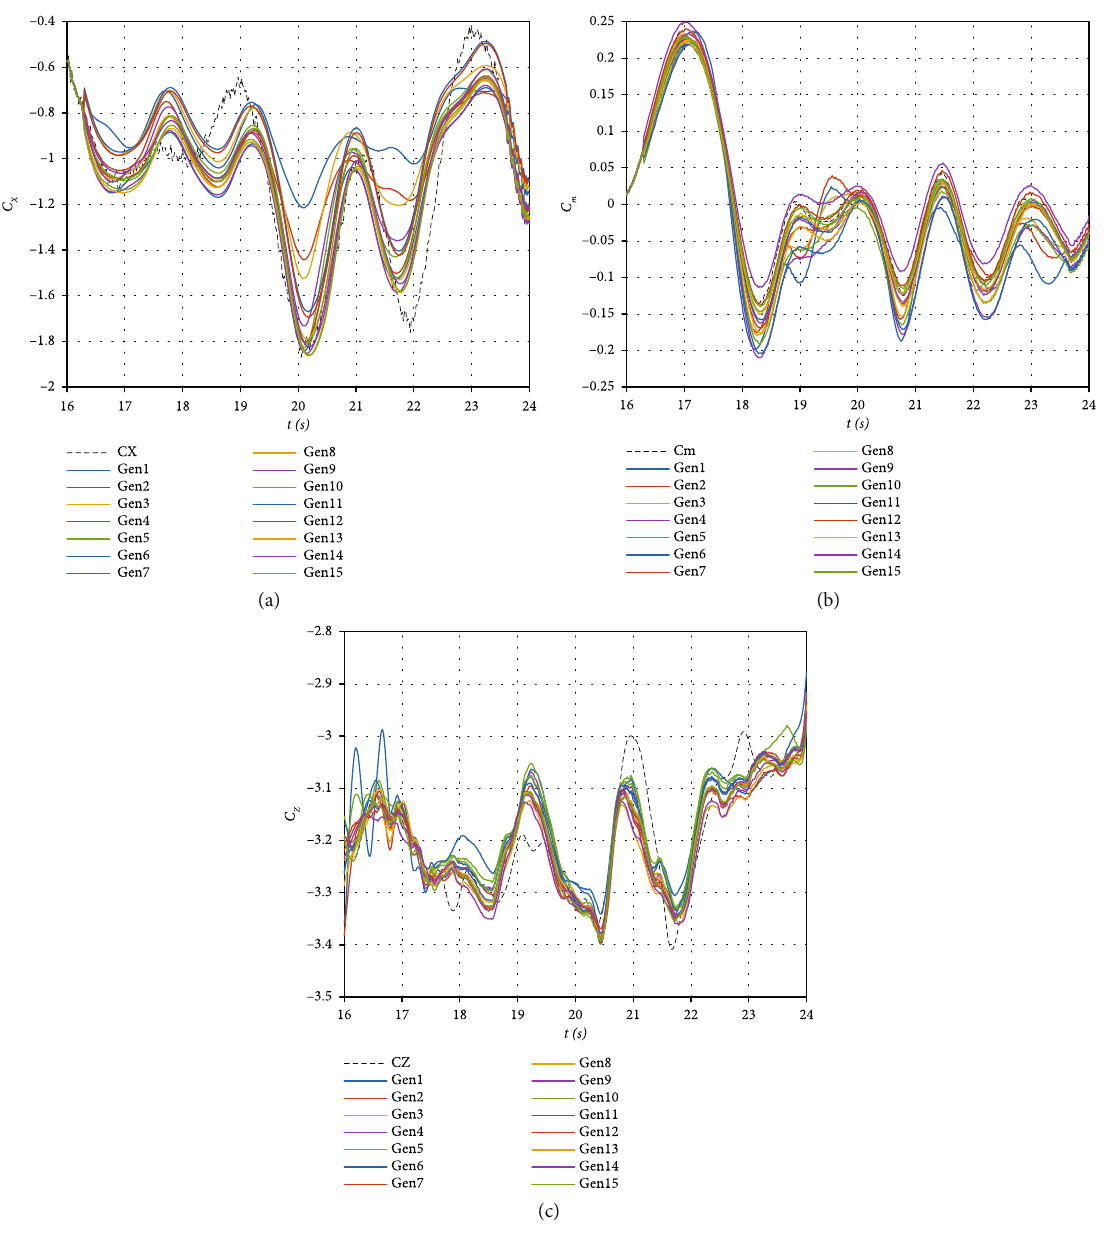
, (b) C , and (c) C X m